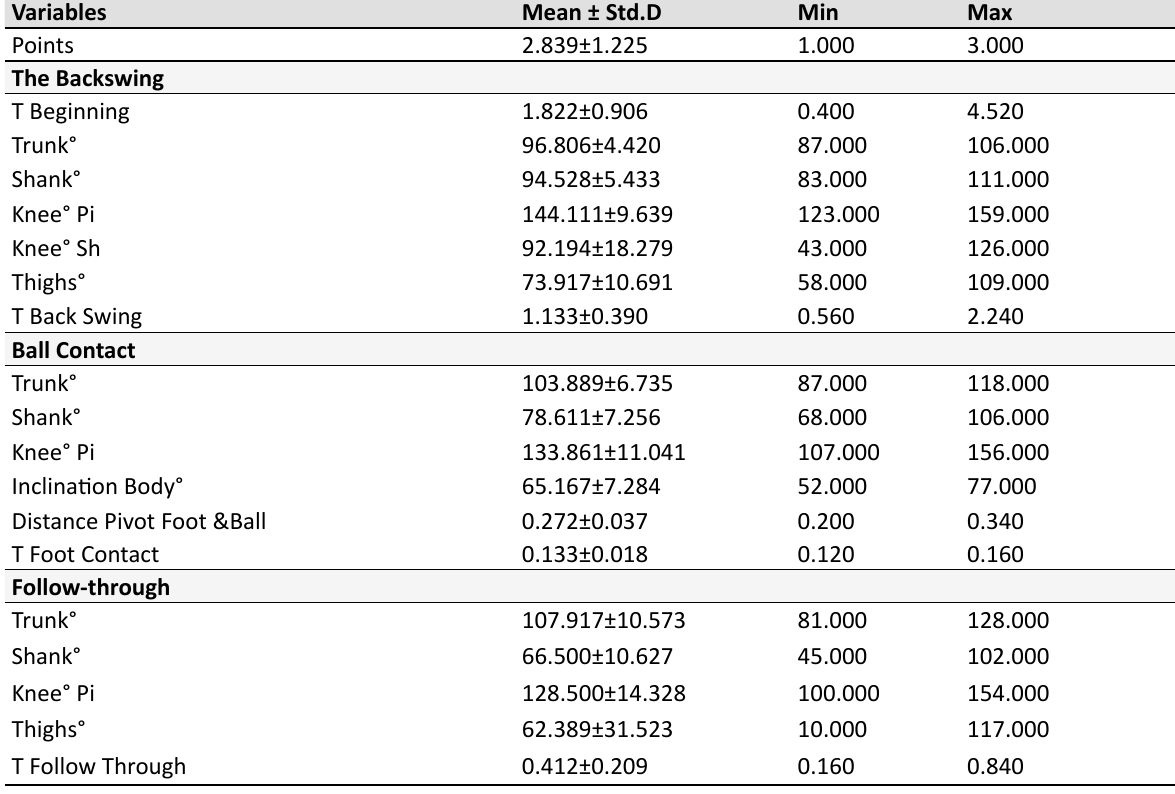
Table 1. Mean, standard deviation, minimum and Maximum values of